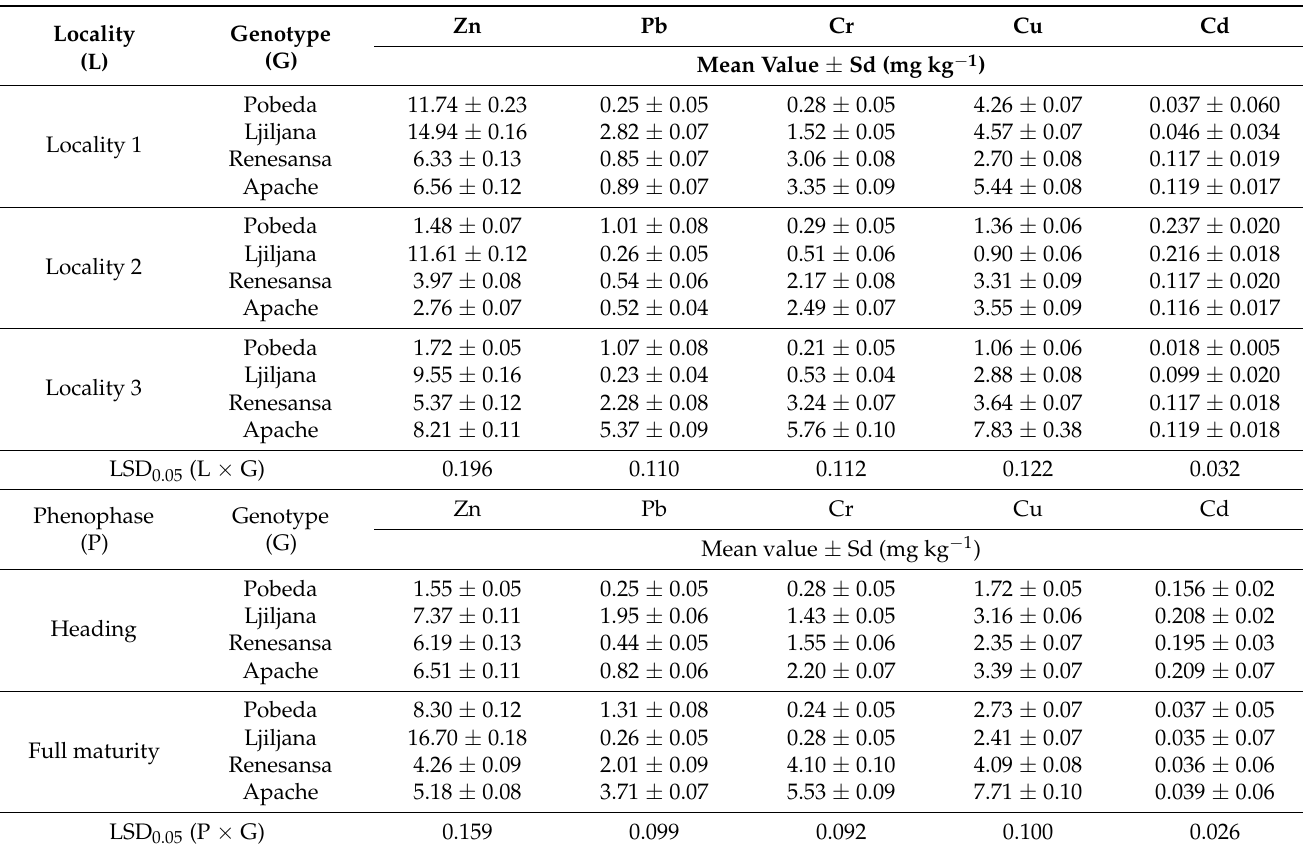
Table 3. Heavy metal content (mean values ± standard deviation of sample means) in the stems of four wheat genotypes per locality (average values for both phenophases) and per phenophase (average values for three